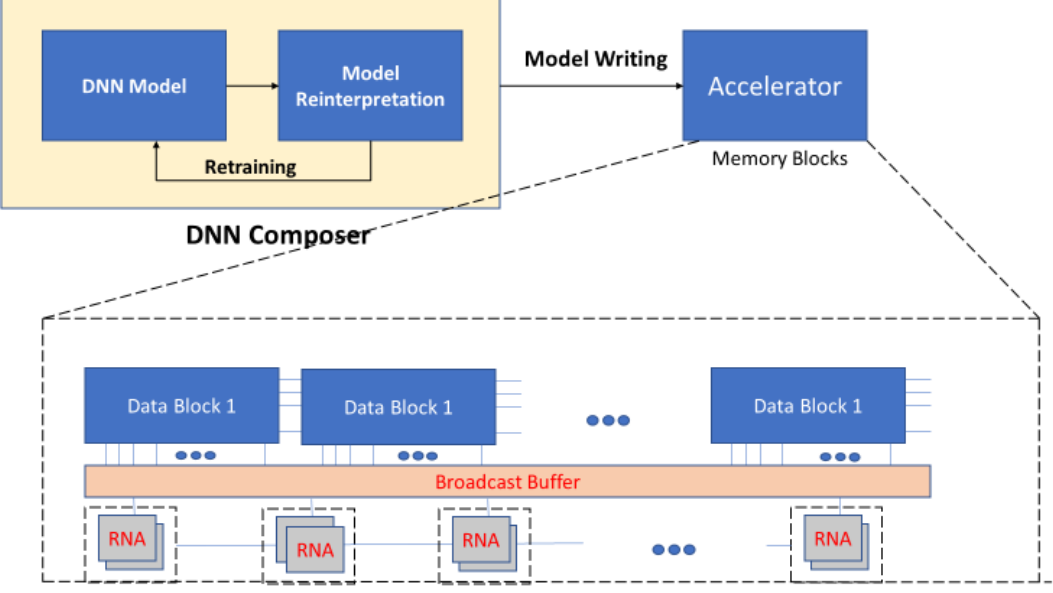
Figure 11. Outline of RAPIDNN architecture [8].